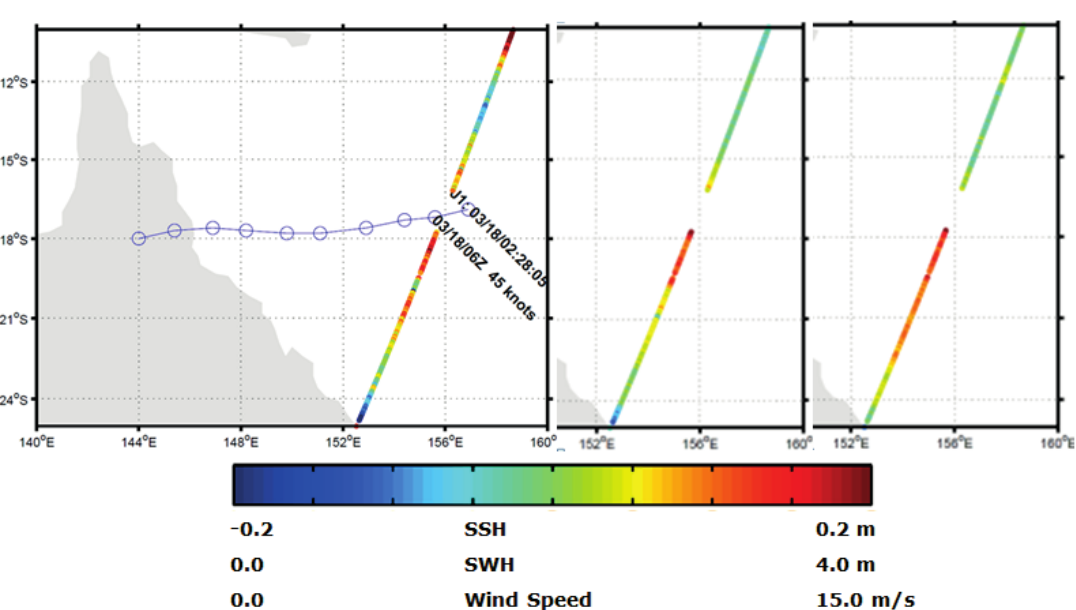
Fig. 5 Altimetric observations from RADS showing all tracks within 12 hours and 500 km of tropical cyclone Larry. In the case of Cyclone Larry only one track from Jason-1 could be used. Left figure shows sea surface height, central figure shows significant wave height and right figure shows the wind speed. The units are shown in the figure. The path of Cyclone Larry is highlighted in the left figure.